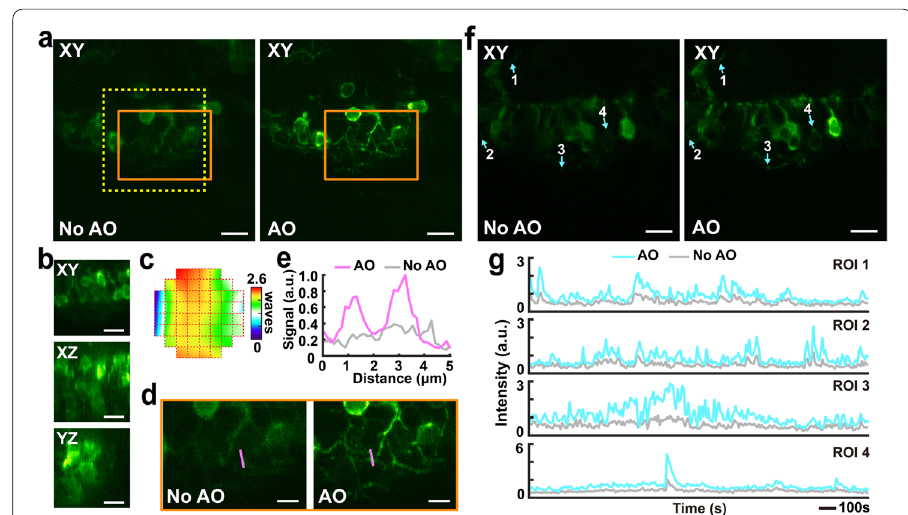
Fig. 7 AO improves in vivo structural and functional imaging in the hypothalamus of a zebrafish larva. a Maximum intensity projection of the neuronal structures 262–267 μm below the skin without and with AO correction. b Maximum intensity projection of the neuronal structures axially centered 274 μm below the skin, which were used for aberration measurement. c Corrective wavefront. The dashed squares indicate the layout of the wavefront segments, where each wavefront segment corresponds to a unit square. A 2 1 1 stepped overlapping mask approach was used in the measurement process. d Zoomed-in views of the × orange boxes. e Intensity profiles along the pink lines in ( d ). f Maximum intensity projection over time of a plane 279 μm below the skin without and with AO correction. g Fluorescence signals during calcium imaging at four regions of interest (ROIs) without and with AO correction. The ROIs are marked by cyan arrows in ( f ). Scale bars, 10 μm in ( a ), ( b ), and ( f ) and 5 μm in ( d